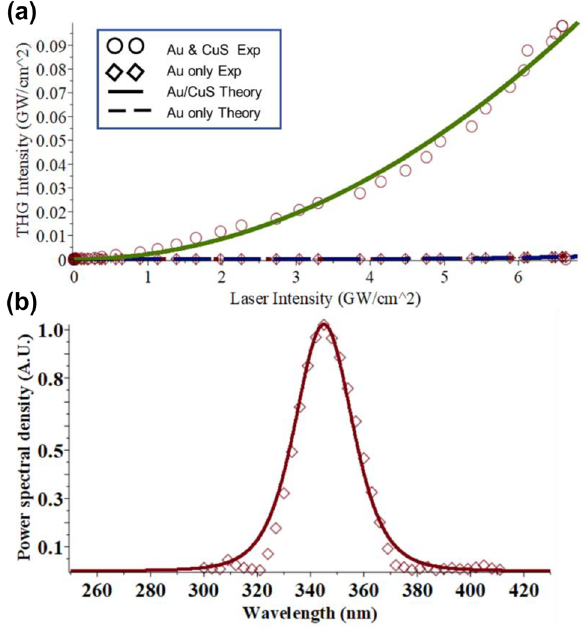
Figure 4: Correlation between experimental results and predicted values from dipole–dipole analytic model. (a) THG signal as a function of input intensity from predicted from analytic model for: 15 nm diameter Au and CuS nanoparticle hybrid film (solid green) and Au nanoparticle only (dashed purple). Experimental data (Figure 2b) from bilayer films are plotted as circles and data from single species films with diamonds. (b) The predicted output intensity of upconverted light at various wavelengths, diamonds are experimental data from Figure 1b. Line theoretical fit centered on 3 𝜔 with a fitting full width at half max of 25